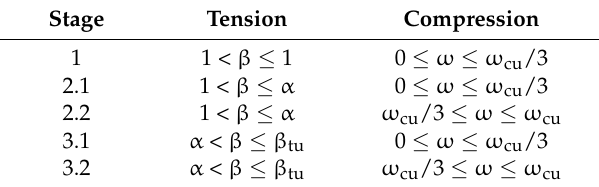
Table 1. The range of compression and tension for each stage of applied strain at the most tensile fiber ( β ). Stage Tension